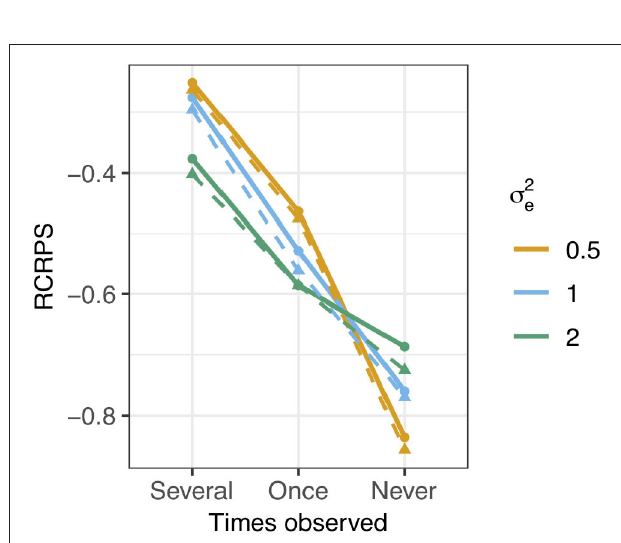
FIGURE 4 | RCRPS (smaller values indicate that the HN or mutation models, respectively, are better than the reference IH model) between the HN model and the IH model (solid line) and between the mutation model and the IH model (dashed line) for data simulated from the mutation model with varying residual variance σ 2 e and empirical haplotype variance 1 [Var( h ) scenarios show RCRPS for the haplotypes that were observed in (Several) several phenotyped individuals, (Once) only one phenotyped individual, and (Never) were not observed in a phenotyped individual.